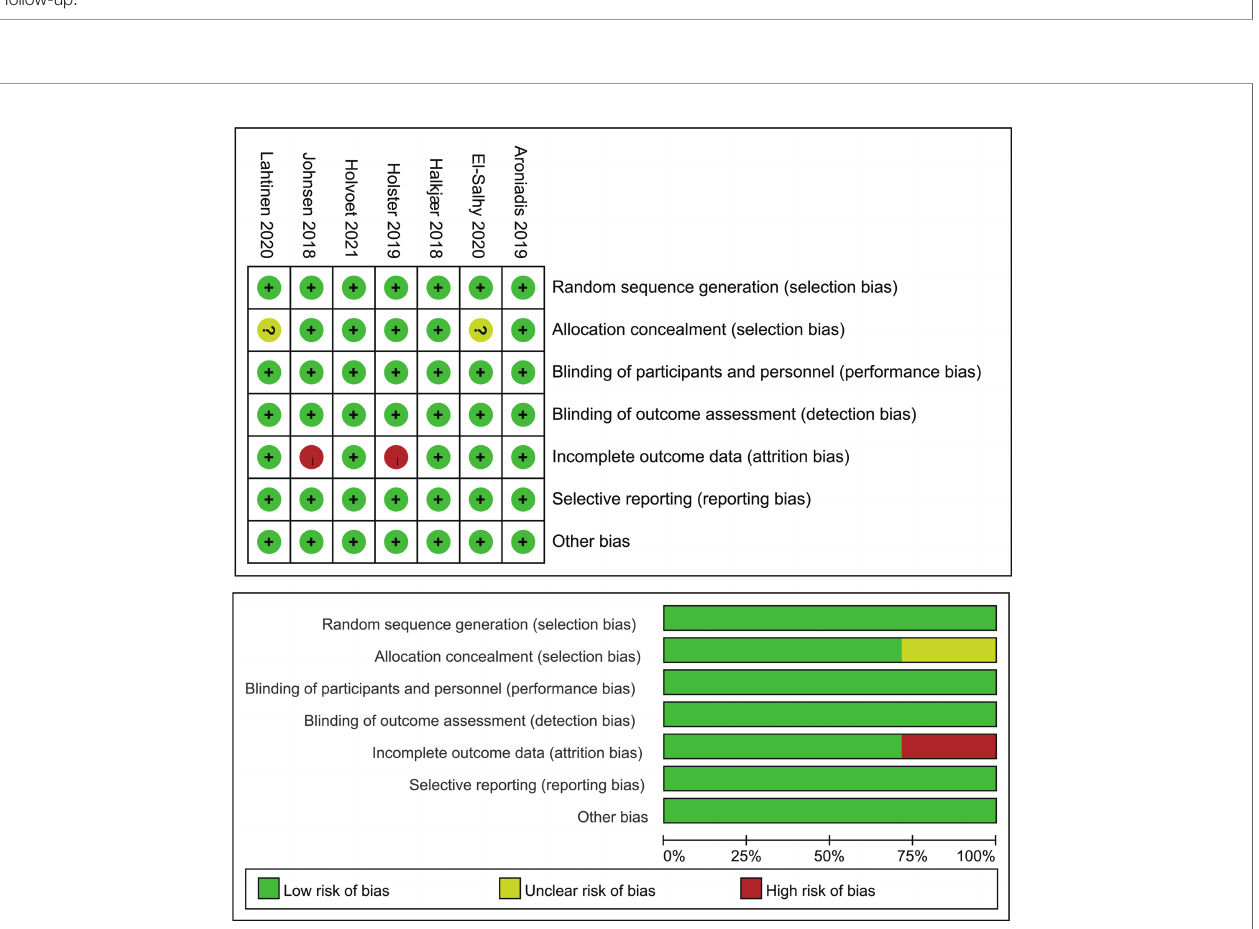
FIGURE 6 | Risk-of-bias assessment of randomized controlled trials using Cochrane risk of bias